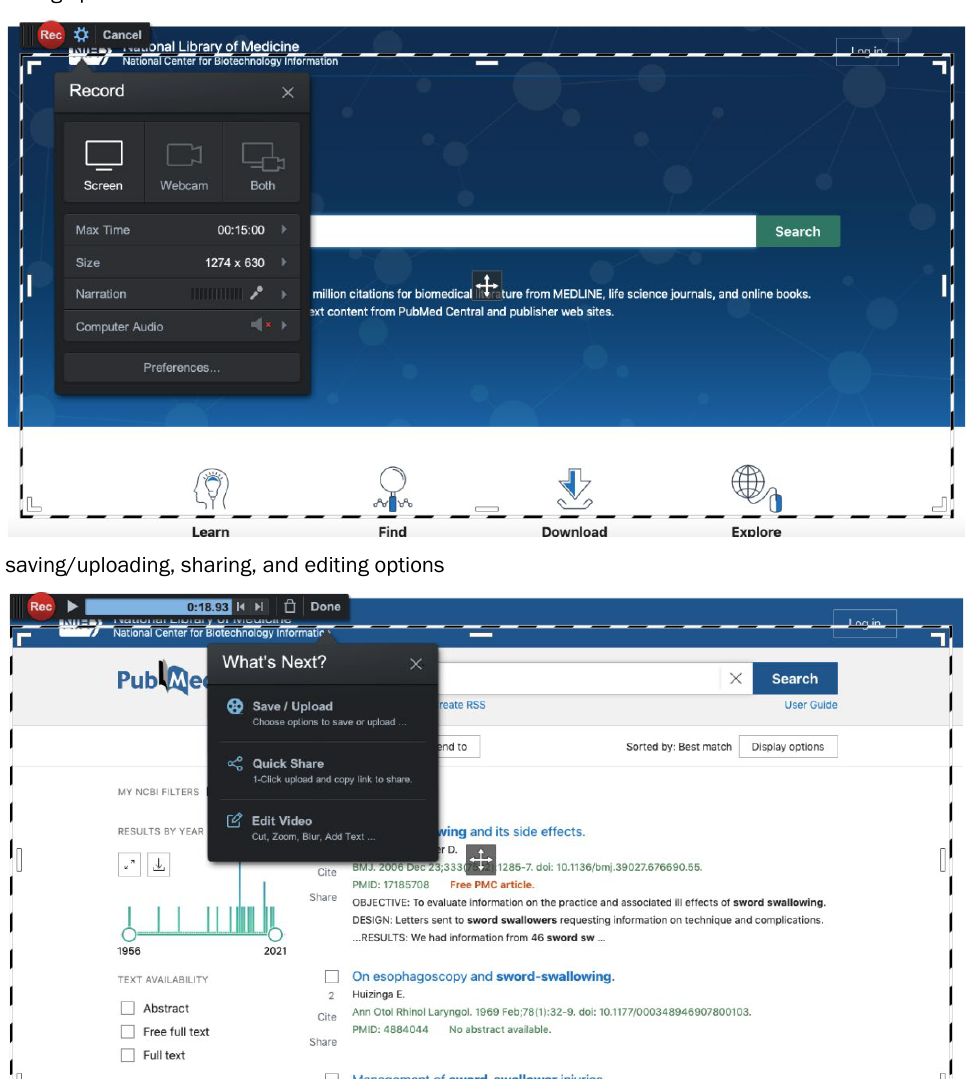
Figure 1 Recording options and frame